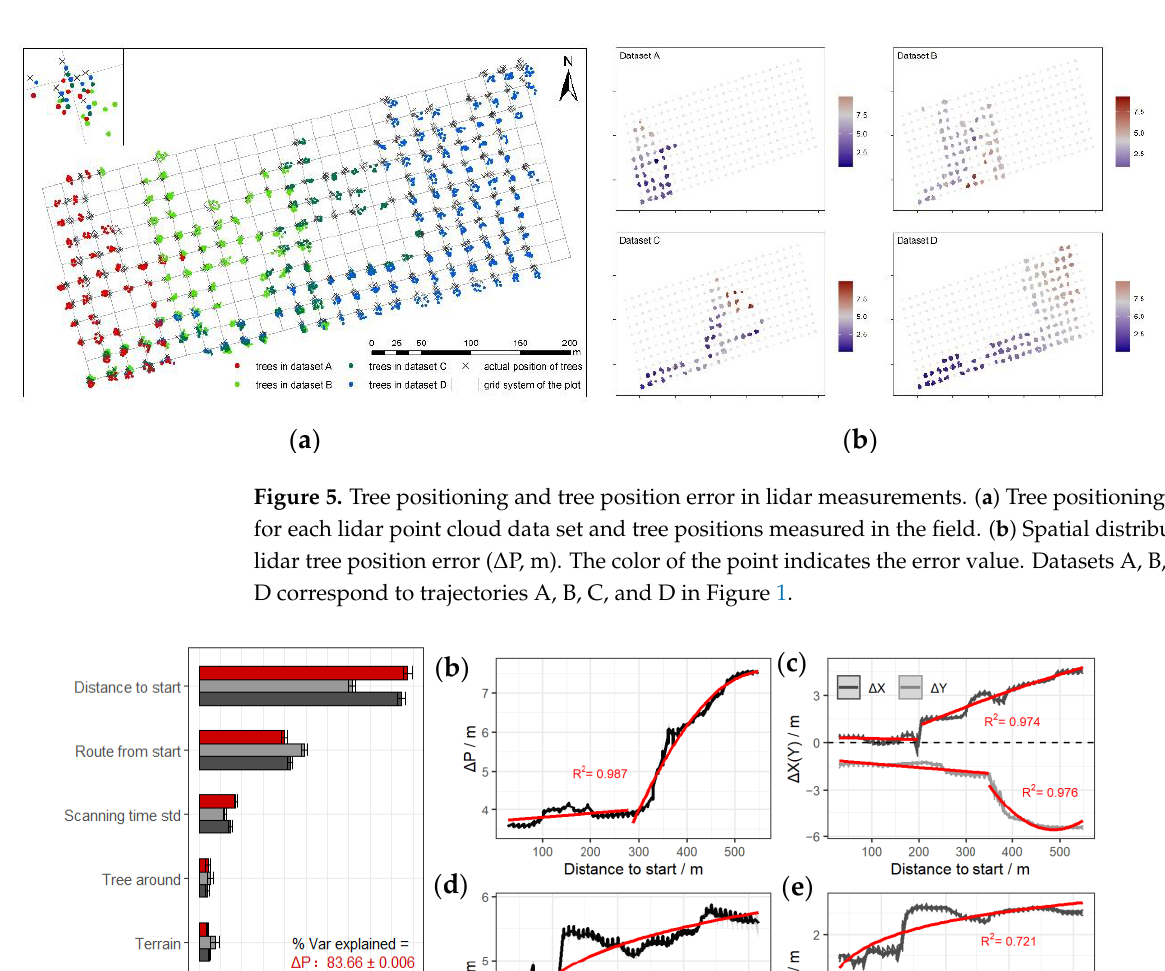
Figure 5. Tree positioning and tree position error in lidar measurements. ( a ) Tree positioning re-